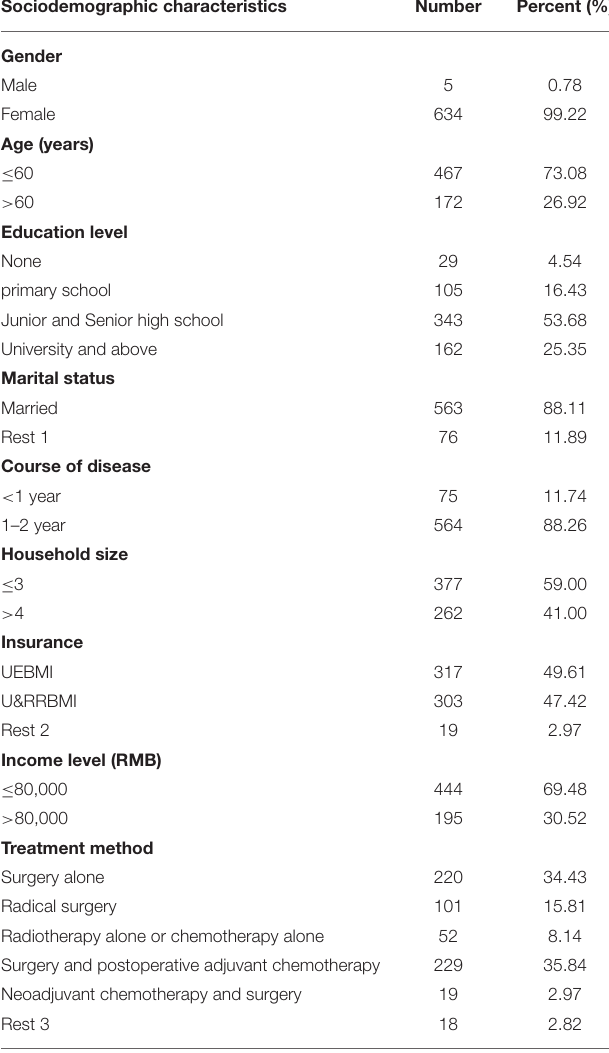
TABLE 1 | Participant